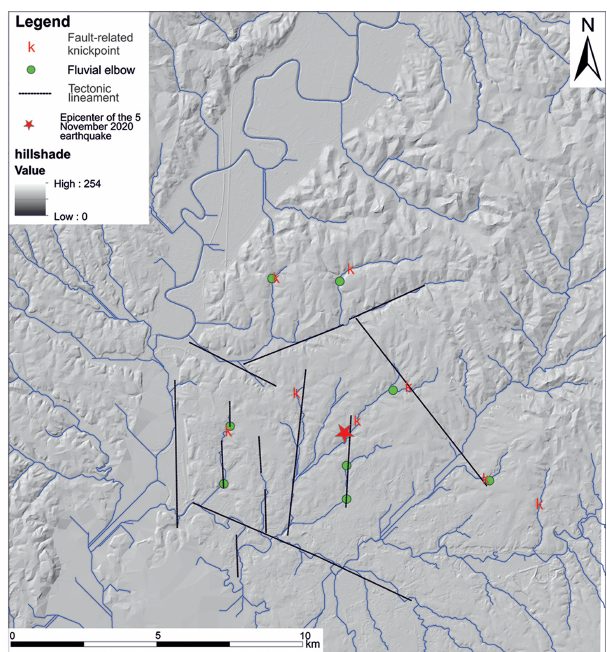
Figure 8. Tectonic lineaments of the study area inferred by morpho- tectonic analyses and the spatial distribution of the main drainage network anomalies of the study area (i.e., fluvial elbow and knick- points of river profiles). Hillshade was derived by the 10m TINI- TALY DEM, published with a CC BY 4.0 license by Istituto Nazionale di Geofisica e Vulcanologia (INGV), available at: https: //doi.org/10.13127/TINITALY/1.0.